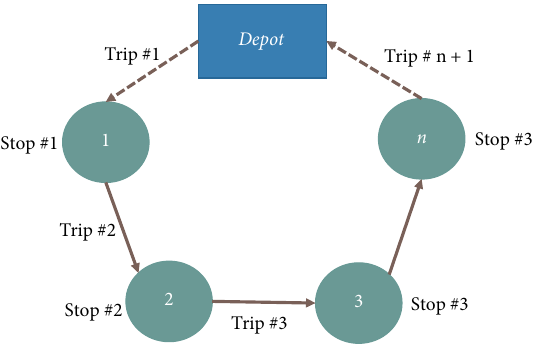
Figure 3: Definition of tour